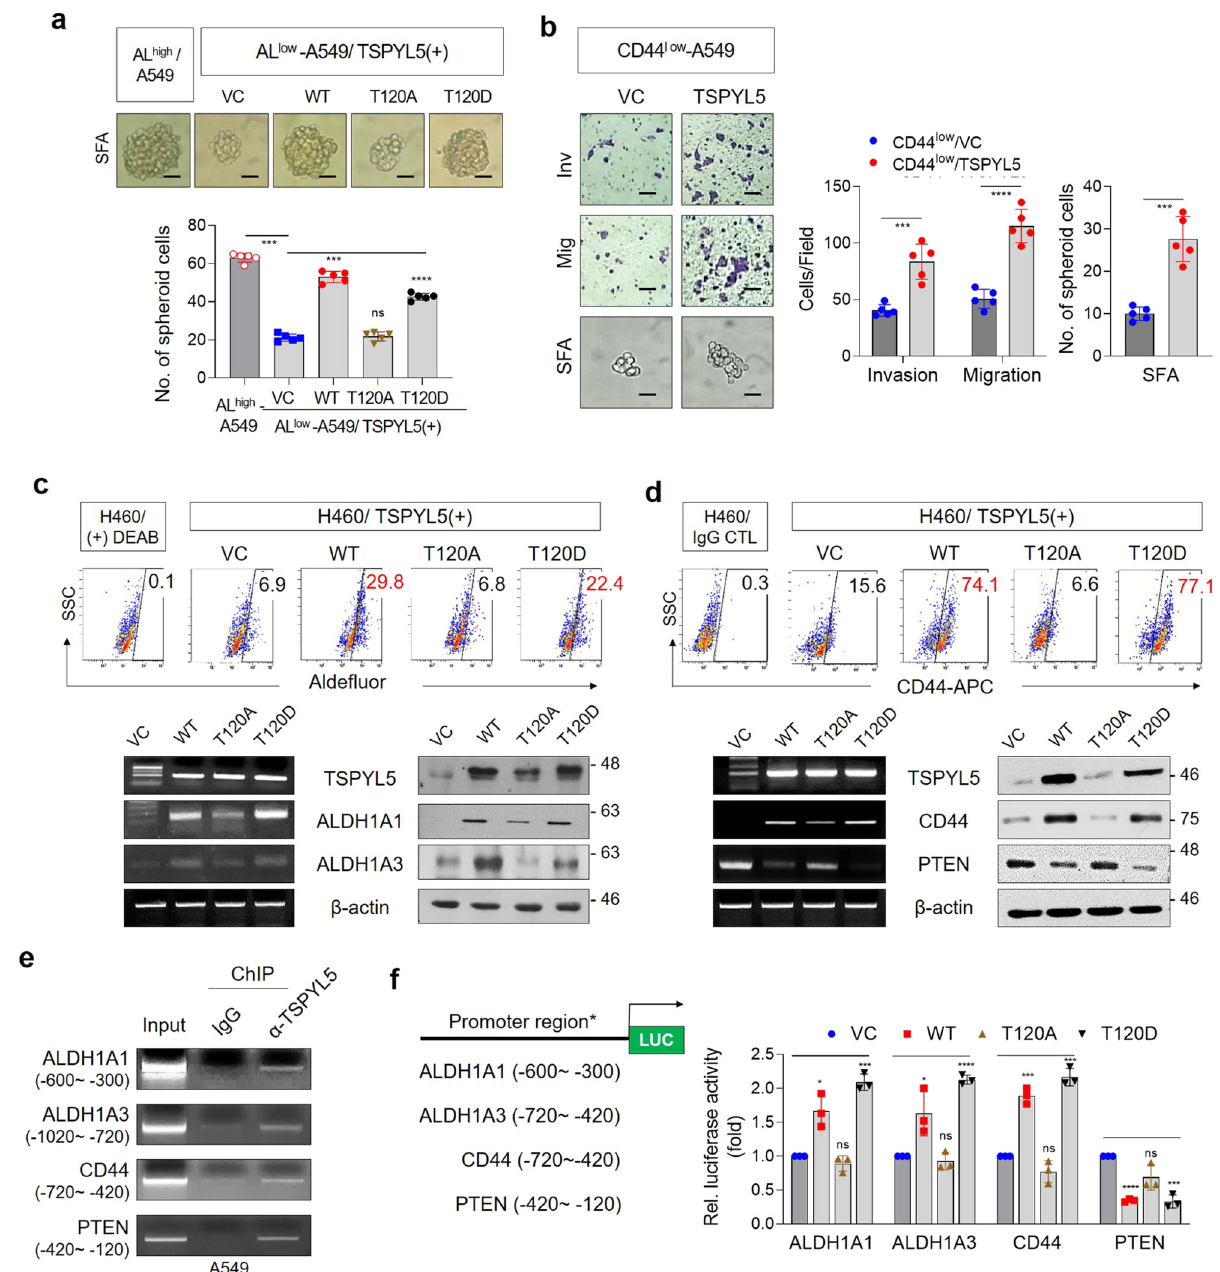
Fig. 7 Phosphorylation of threonine-120 in TSPYL5 is critical for CSC-like characteristics of cancer cells by driving transcriptional activation of CSC- related factors. a Sphere-formation assay of ALDH1 low A549 cells transfected with WT or site-directed mutagenic TSPYL5 expression vectors (T120A and T120D). ALDH1 high A549 cells were used as control. n = 5 independent experiments. Scale bar: 20 μ m. b Invasion/migration and sphere-formation ability of CD44 low cells following transfection with WT-TSPYL5 expression vector. n = 5 independent experiments. c ALDH1A1/A3 expression analyzed by fl ow cytometric analysis with Alde fl uor stainining in H460 cells transfected with non mutagenic (WT: T120) or site-directed mutagenic TSPYL5-expression (T120A or T120D) vectors (upper panel). Sorted cells depending on Alde fl uor staining were restained to use as gating controls. RT-PCR and Western blot analysis were also performed (lower panel). d CD44 expression analyzed by fl ow cytometric analysis with CD44-APC staining in H460 cells transfected with nonmutagenic (WT: T120) or site-directed mutagenic TSPYL5-expression (T120A or T120D) vectors (upper panel). Sorted cells depending on CD44- APC were re-stained to use as gating controls. RT-PCR and Western blot analysis of CD44 and PTEN were also performed (lower panel). e Chromatin immunoprecipitation (ChIP) assays with TSPYL5 antibody evaluating the effect of TSPYL5 on the transcriptional regulation of ALDH1, CD44, and PTEN in A549 cells. PCR for ChIP assay was performed using primers (Supplementary Table 7) positioned between − 900 and + 120 bp upstream of transcriptional start site of each gene (Supplementary Fig. 8) and representative results were shown. f Luciferase assay evaluating the effect of TSPYL5 on ALDH1, CD44, and PTEN expression in H460 cells transfected with WT or mutagenic TSPYL5-expression vectors (T120A and T120D). Promoter reporter vectors were constructed with speci fi c promoter regions of each gene, which were ampli fi ed in ChIP assays as shown in the schematic representation. n = 3 independent experiments. Data represent mean ± s.d. using two-tailed t -test. NS not signi fi cant, * p < 0.05, ** p < 0.01, *** p < 0.001, **** p <